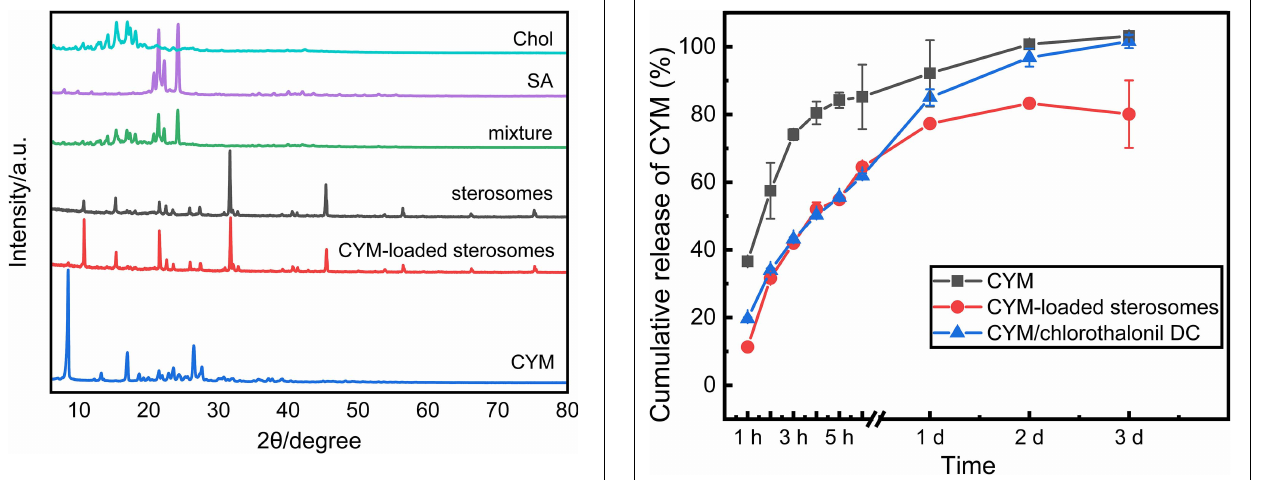
FIGURE 3 | X-ray diffraction patterns of different components of sterosomes and CYM-loaded sterosomes.